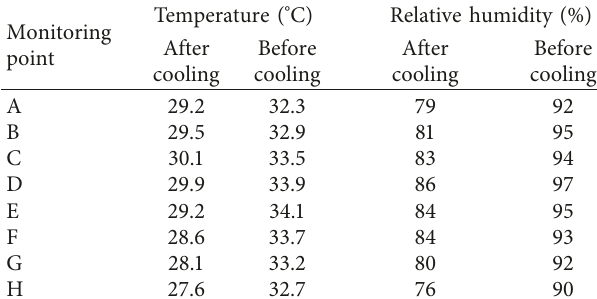
Figure 5: Layout of measuring points in the west tunnel of the middle section of 280m. Table 3: Temperature and humidity monitoring data before and after cooling.